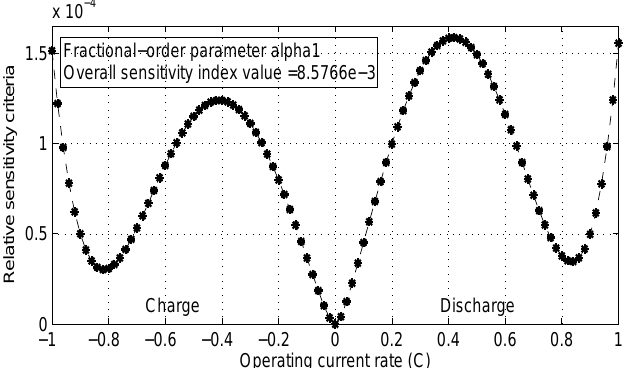
Figure 11. Sensitivity index values of sensitive parameter fractional-order factor α 1 at different operating current values.